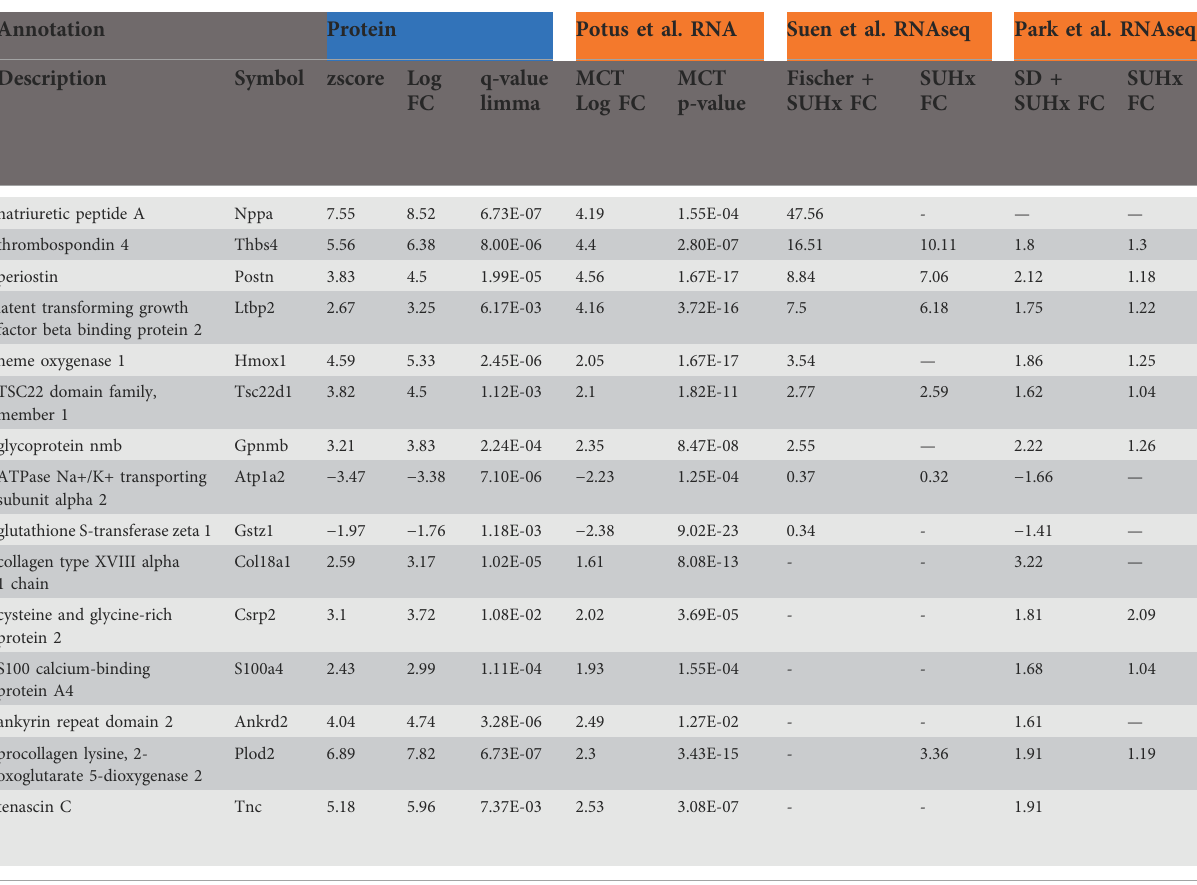
TABLE 2 List of highly enriched proteins (q-value < 0.05 & z-score ± 1.96) that also have highly enriched transcripts (FDR < 0.05 & fold change > 1.5) in our previously published work (Potus et al.,2018), in data published from the right ventricle (RV) from Fischer rats + Sugen5416 + hypoxia